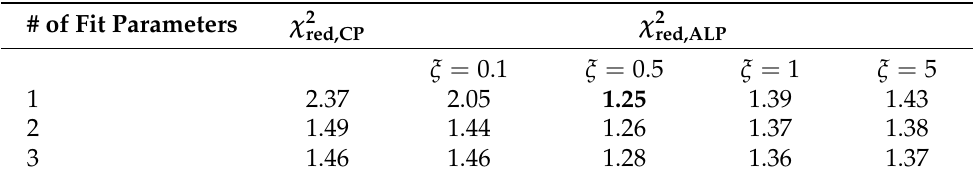
Table 2. Same as Table 1 but for L dom =